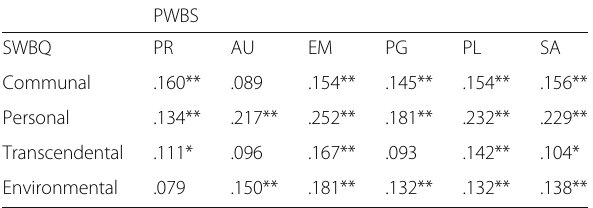
Table 4 Pearson ’ s correlations between SWBQ b and PWBS dimensions